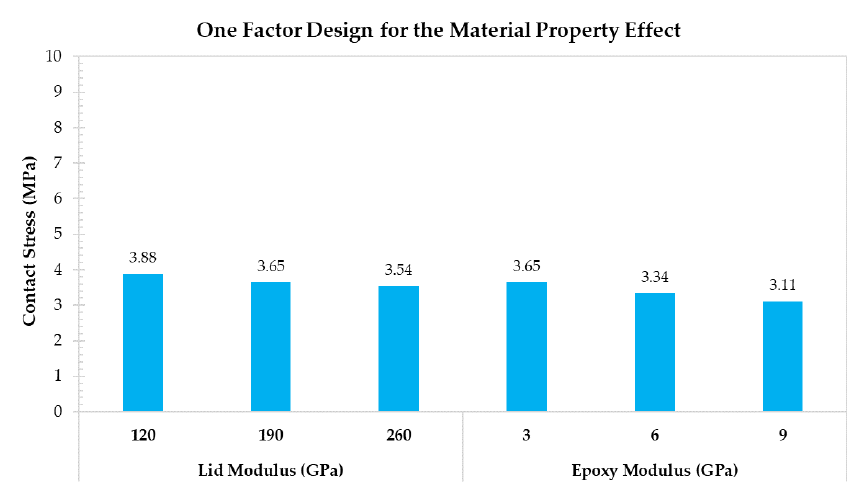
Figure 12. One factor design for discussing the lid geometry effect.